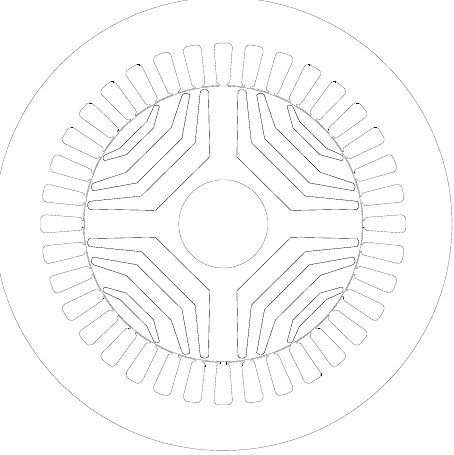
Figure 7. Cross-section of the five-phase SynRM.